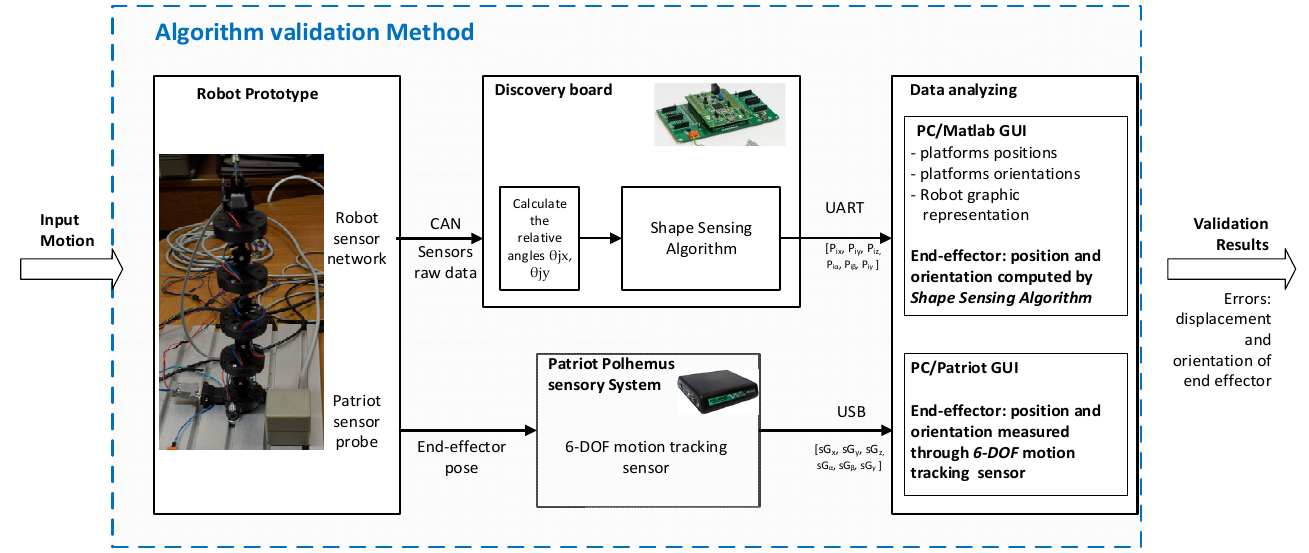
Figure 6. Conceptual diagram of the testing method for the end-effector pose .